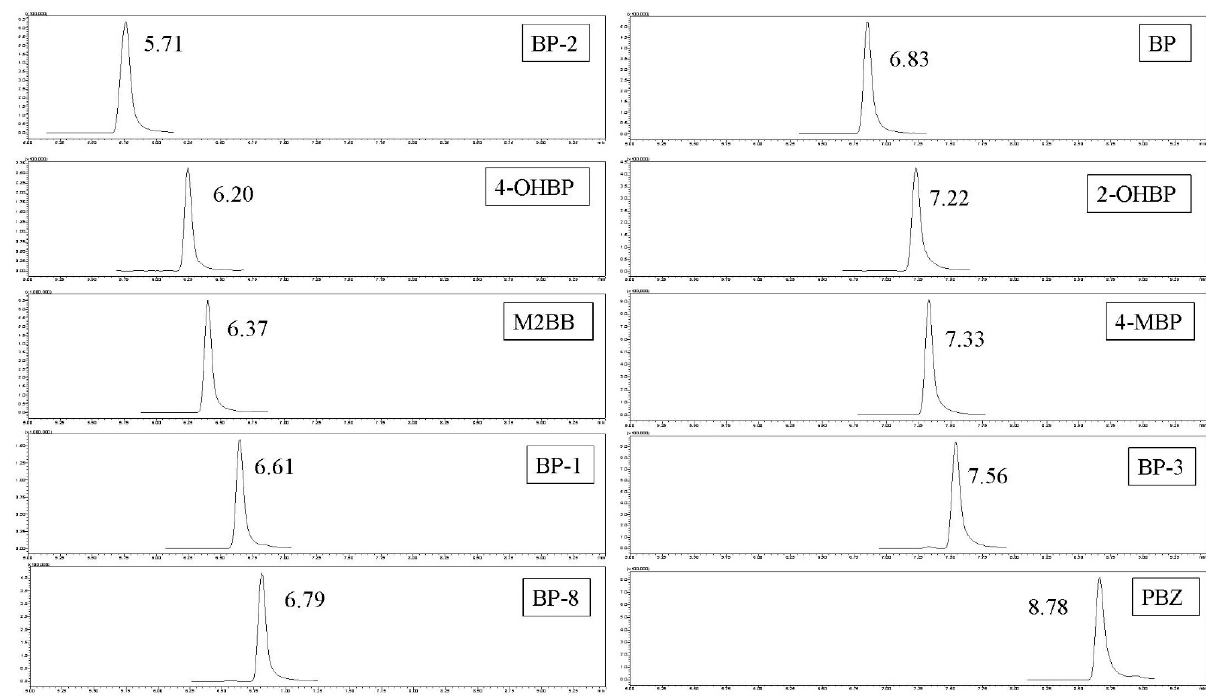
Figure 3. Chromatograms of a solvent-spiked sample of BP and BP analog standards at 80 ng/g.